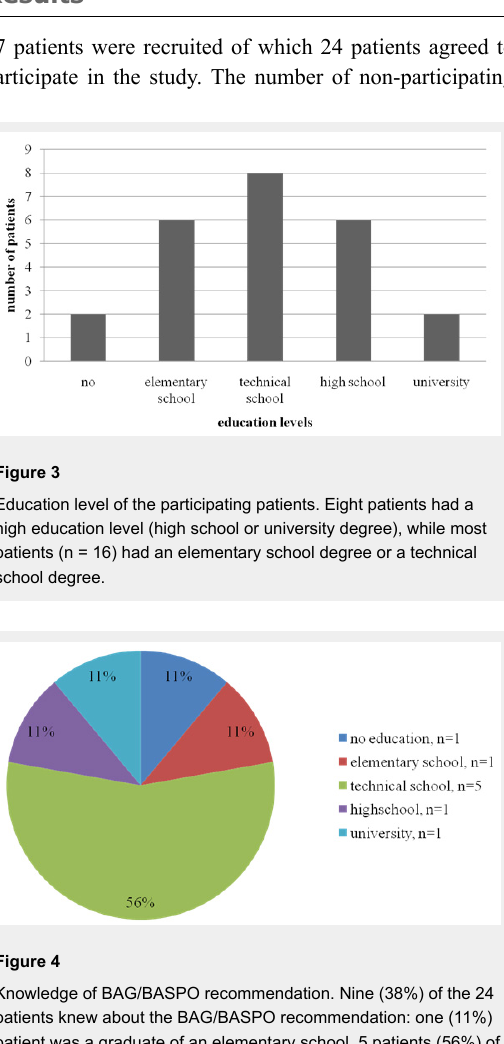
Origin of the participating patients. Of the study population 59% (n = 14) were foreigners (i.e., not citizens of Switzerland), 33%, (n = 8) were Swiss, two citizens of Switzerland (8%) had a migration background.